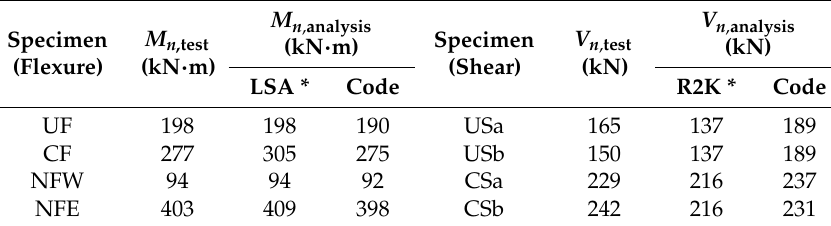
Table 4. Comparison of the test and analysis results.